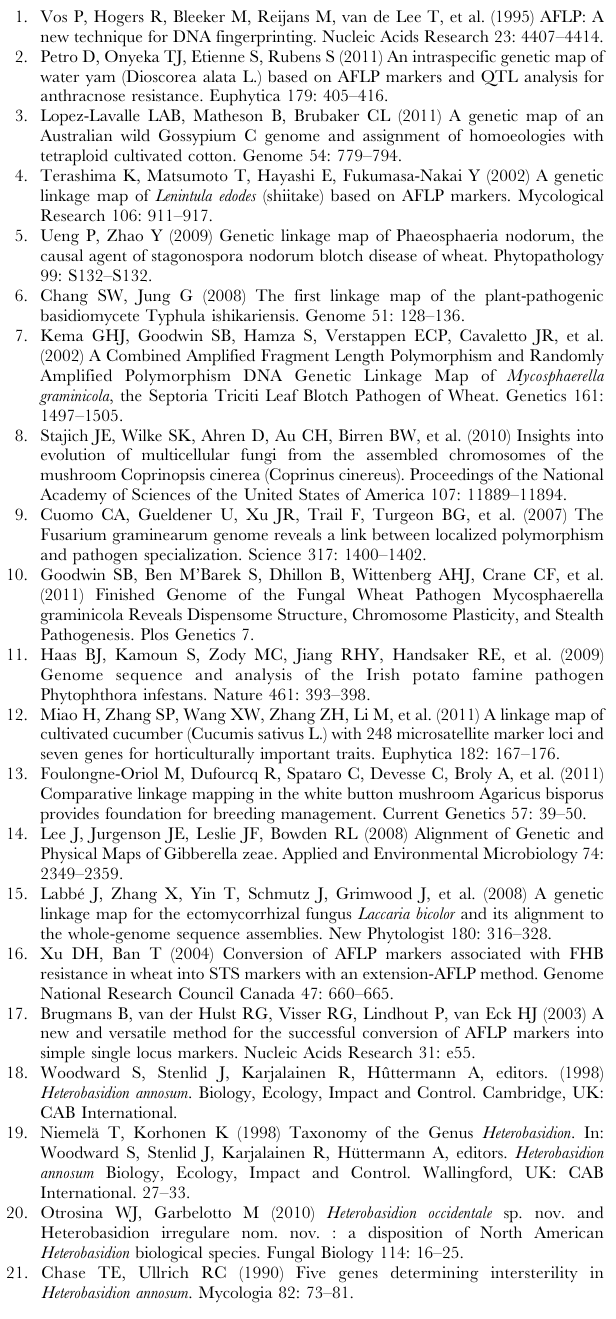
Table S1 Primer combinations for every microsatellite marker or mapped gene in the 2 nd generation linkage map of Heterobasidion annosum